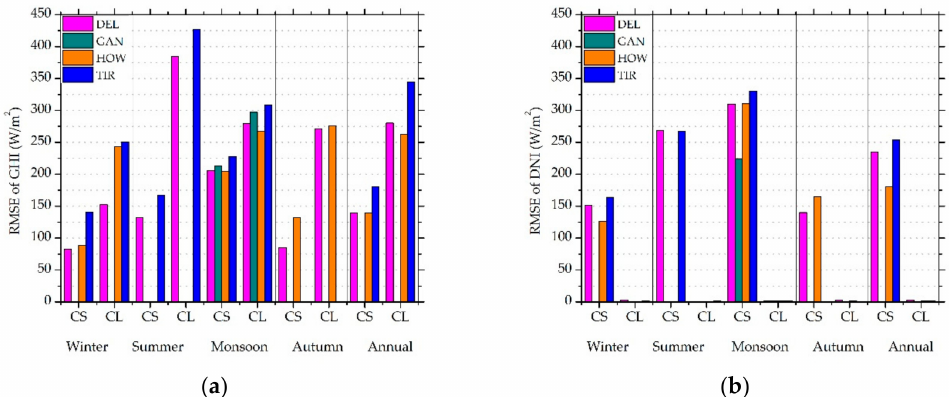
Figure 7. Seasonal RMSE values of GHI ( a ) and DNI ( b ) estimations from RTM simulations and INSIOS technique, as compared to BSRN